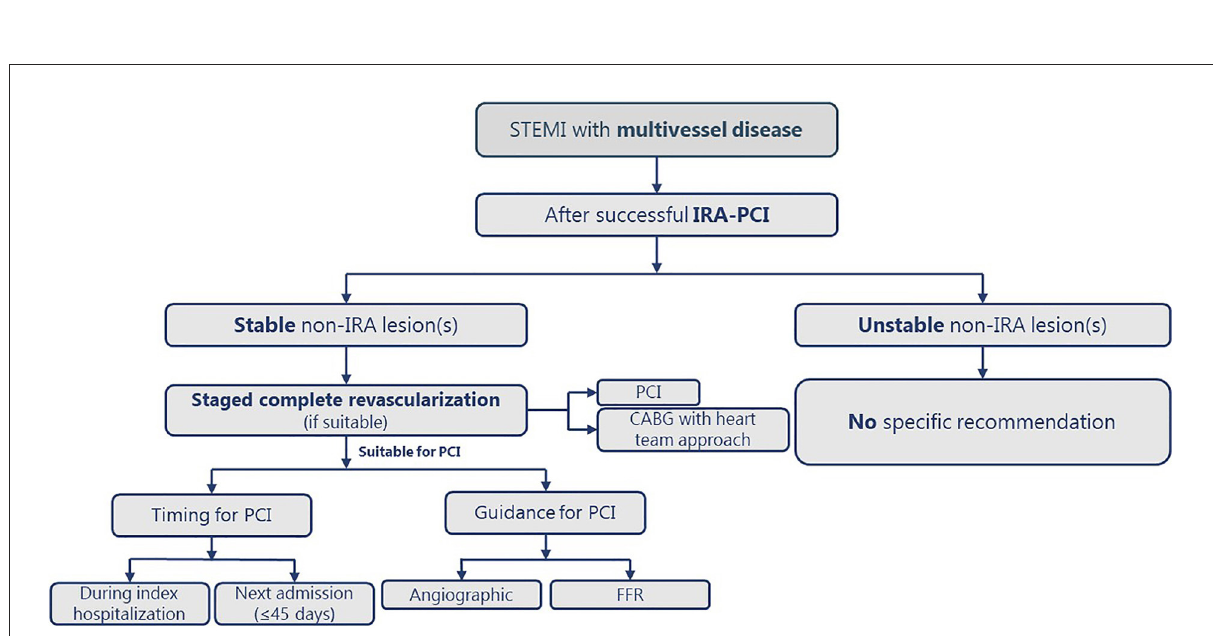
FIGURE2 The practical approach for complete revascularization in patients with STEMI and MVD. CABG, coronary artery bypass graft; CS, cardiogenic shock; FFR; fractional flow reserve; IRA, infarct-related artery; MVD, multivessel disease; PCI, percutaneous coronary intervention; STEMI, ST-segment elevation myocardial